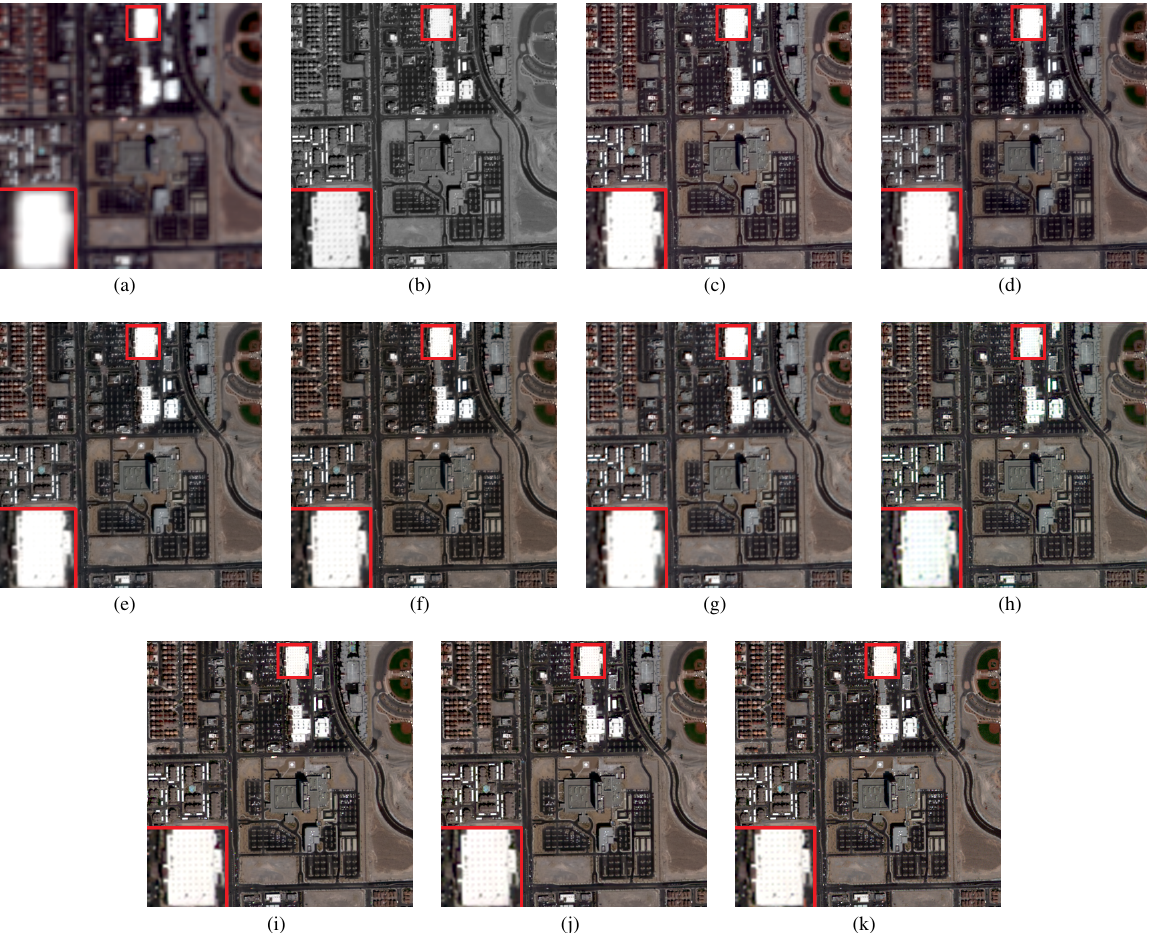
Figure 5. Comparison of pan-sharpening results obtained by different methods (reduced-resolution). (a) Low-resolution MS image. (b) PAN image. (c-j) Pan-sharpening results of BDSD, MMP, MTF-GLP, GLP-SEGM, PNN, MSDCNN, CSN, and CSN-SSL. (k) Reference image.